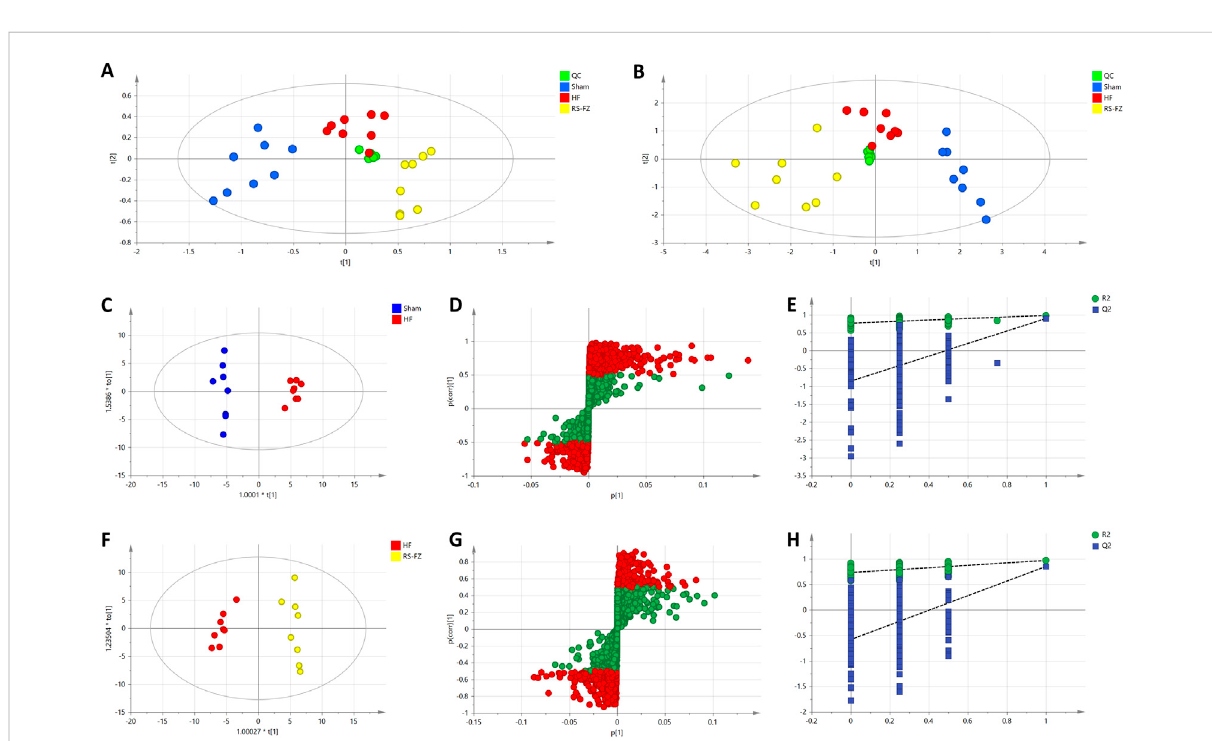
FIGURE 4 Multivariate statistical analysis results (A) PCA score plot of the Sham, HF, and RS-FZ groups in ESI + mode. (B) PCA score plot of the Sham, HF, and RS-FZ groups in ESI- mode (C) OPLS-DA score plot of Sham and HF groups in ESI- mode (D) S-plot of the OPLS-DA model for Sham and HF groups in ESI- mode; (E) The 200-permutation test for Sham and HF groups in ESI- mode (F) OPLS-DA score plot of HF and RS-FZ groups in ESI- mode; (G) S-plot of the OPLS-DA model for HF and RS-FZ groups in ESI- mode (H) The 200-permutation test for HF and RS-FZ groups in ESI-